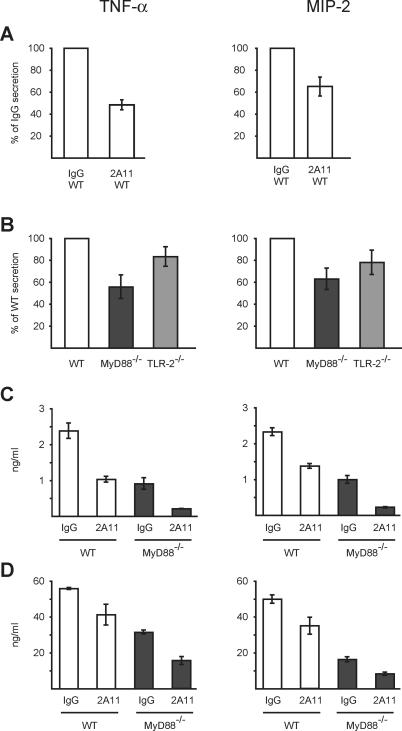
Dectin-1- and MyD88-Mediated Signals Are Induced by A. fumigatus Conidia(A–D) WT (white bars, [A–C]), MyD88−/− (dark grey bars, [B–D]), and TLR-2−/− (light grey bars, [B]) BMMØs (A–C) or AMØs (D) were stimulated with conidia for 18 h in medium containing 0.5 μg/ml voriconazole, and TNF-α/MIP-2 secretion was measured by ELISA. (A,C,D) BMMØs (A and C) and AMØs (D) were incubated with 2A11 (anti-Dectin-1 mAb) or an isotype control antibody in the presence of 2 μM cytochalasin D. (A and B) ELISA results from test conditions were averaged among three to five experiments and expressed as a percentage ± standard deviation of the averaged value obtained for the control condition. (C and D) show representative experiments.All experiments were performed with three to six replicates per condition.